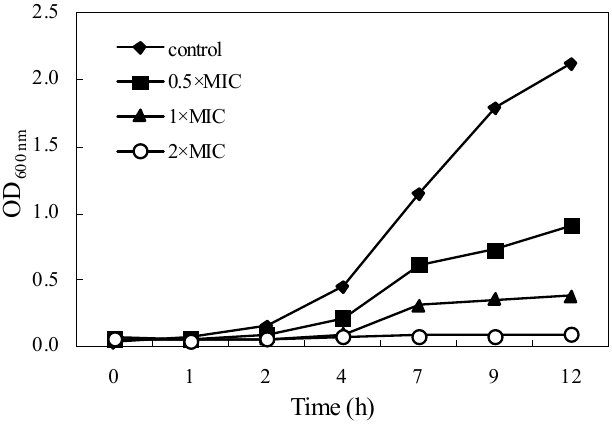
Figure 1. Effect of the essential oil on the viability of S. aureus.